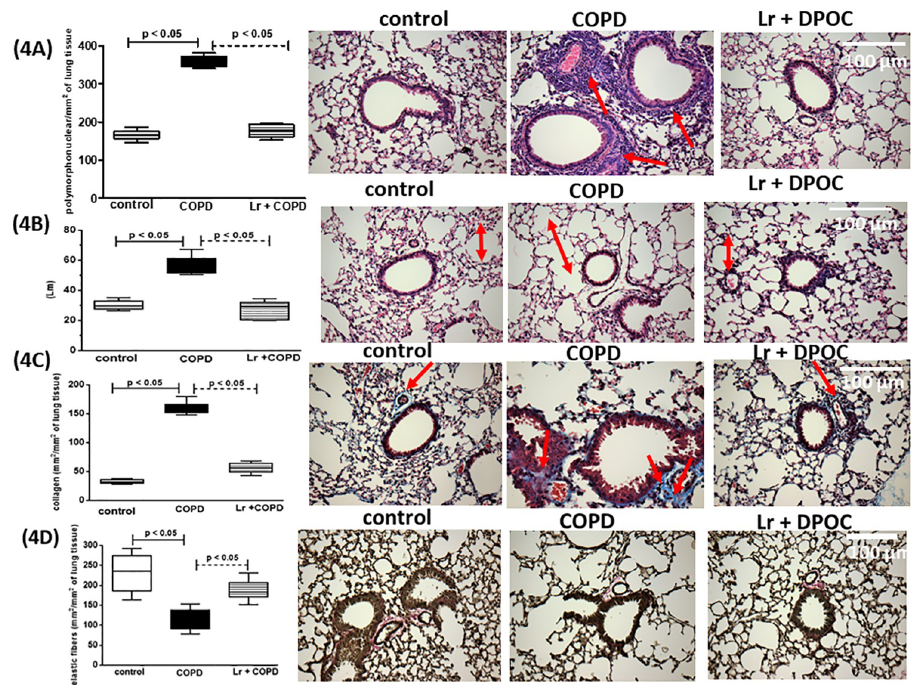
Fig 4. Airway morphometry. After exposure of C57Bl/6 male mice to cigarette smoke and treatment with Lactobacillus rhamnosus ( Lr ), sections (5 μ m) of formalin-fixed lungs were stained with hematoxylin and eosin for histological examination in control, COPD, and Lr + COPD groups. (Original magnification, × 200). (4A) Quantification of polymorphonuclear cells in airway wall, (4B) Alveolar enlargement (Lm), (4C) Collagen fibers deposition, and (4D) Fiber elastics destruction were measured as described in Material and Methods section. Each plot represents mean ± SEM from 7 different animals. Results were considered significant when p <